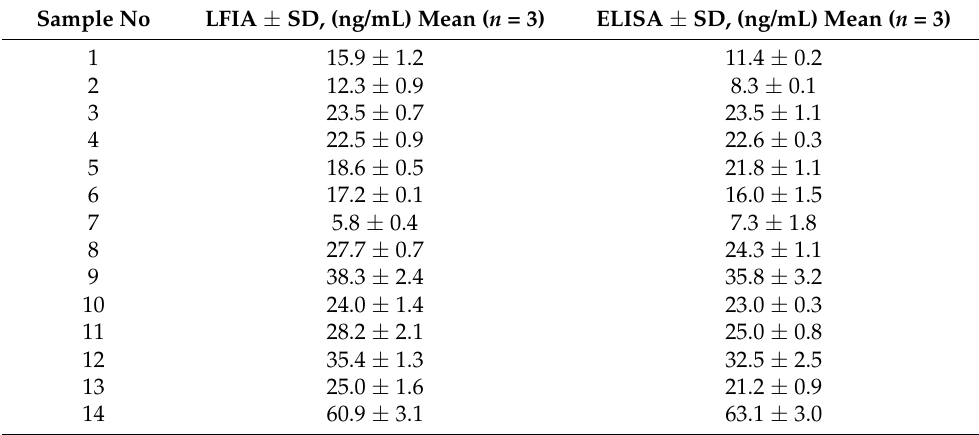
Table 2. Salivary cortisol content determined using developed LFIA test strips and